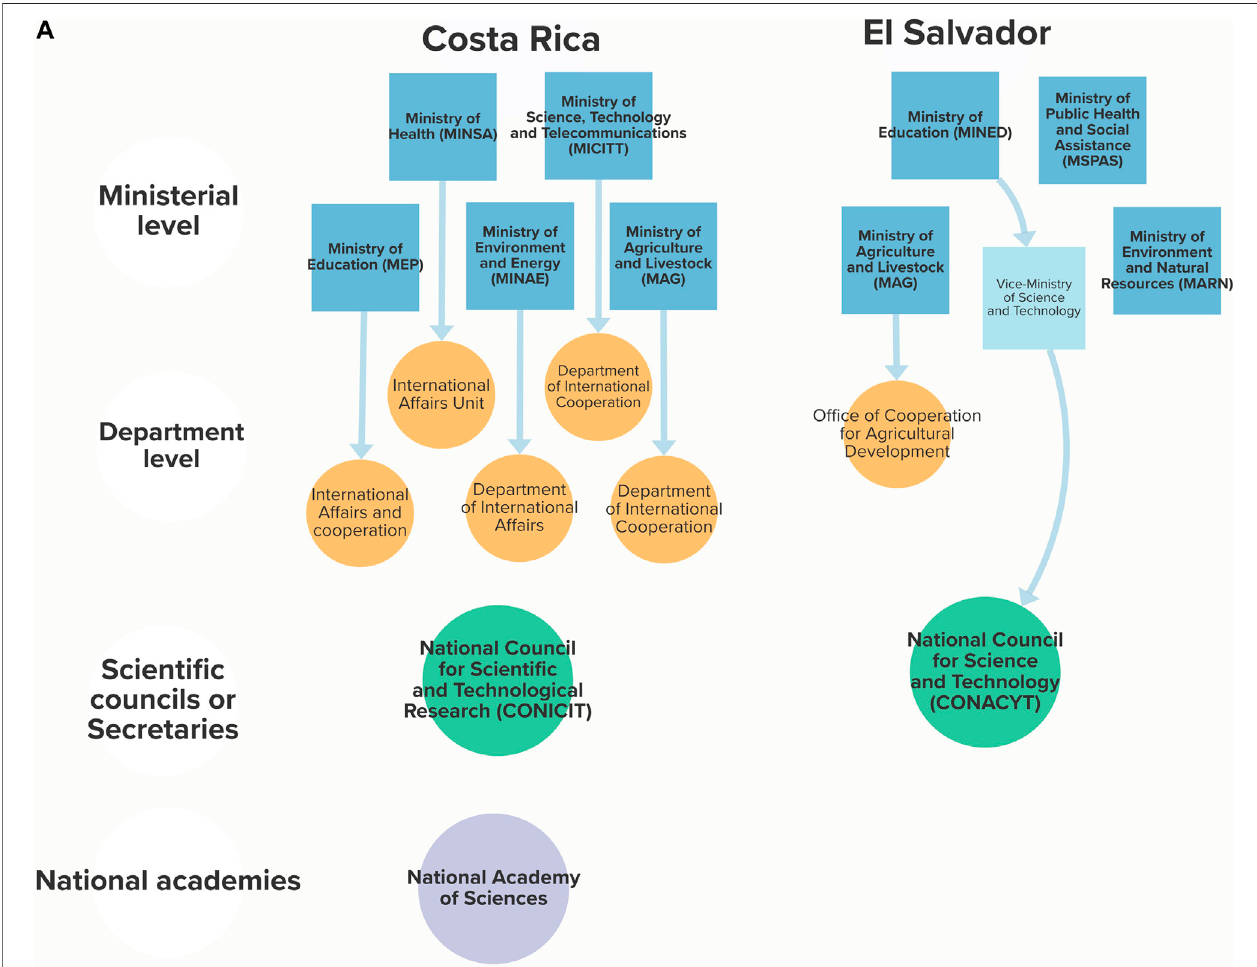
FIGURE1| AmappingoftheinstitutionalcapacitiesforsciencediplomacyinthesixSICAcountries(2021),arrangedbyalphabeticalorder(fromlefttorightandtop to bottom). The fi gure shows the ministries and vice-ministries in blue ( fi rst row) and their international cooperation departments in orange (second row), the scienti fi c councils or secretaries in green (third row) and the national academies in purple (fourth row). Note that some entities may be missing due to speci fi c de fi nitions of ‘ STI institutions ’ (see Research objectives and methods